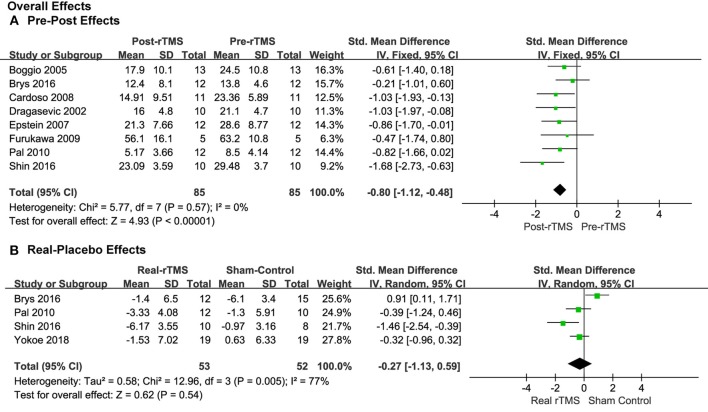
Forest plots of overall effects showed a significant pre-post anti-depressive effect (A) and non-significant real-placebo effect (B).